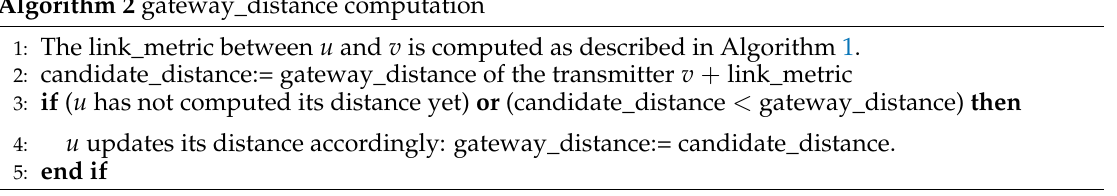
Algorithm 2 gateway_distance